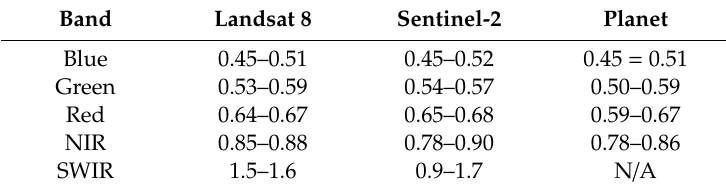
Table A1. Wavelengths (in nanometer, µ m) of spectral bands by di ff erent satellite imagery providers.